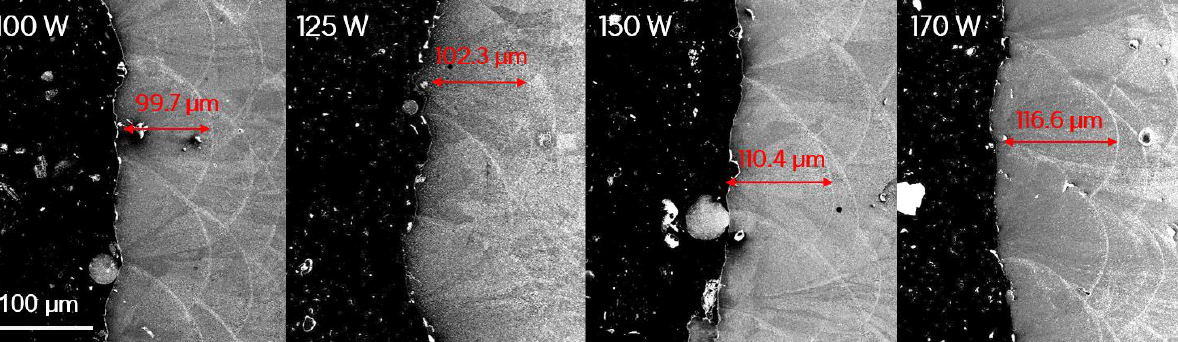
Figure 4. Metallographic images on XZ plane as a function of used power values. The mean melt pool depths are indicated in red.